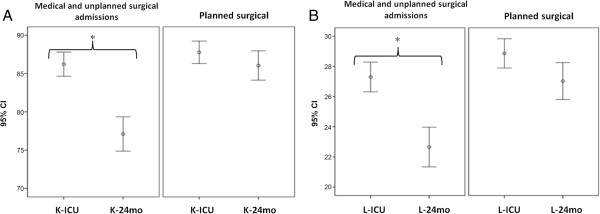
Karnofsky and Lawton scores. A) Comparison between mean K scores (K-ICU vs. K-24mo) and B) mean L scores (L-ICU vs. L-24mo) in medical and unplanned surgical patients and in planned surgical patients admitted to the ICU.